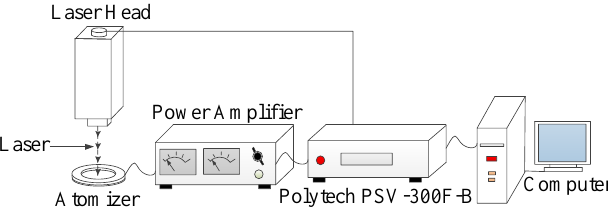
Figure 6. The method used to measure the vibration mode of the piezoelectric vibrator.